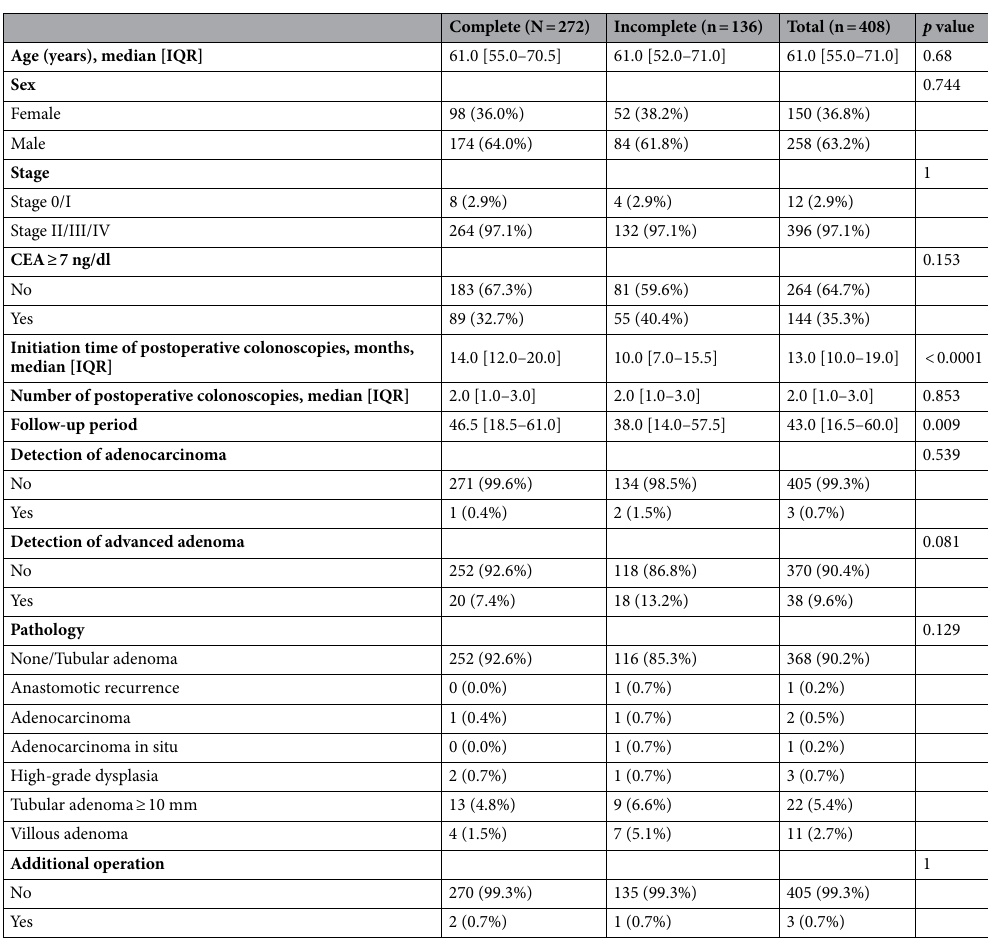
Table 2. Descriptive analyses of baseline pre-surveillance characteristics and surveillance results in the matched cohort. IQR interquartile range; CEA carcinoembryonic